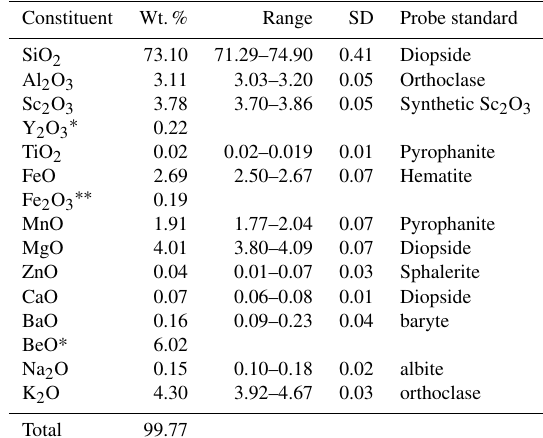
Table 3. Trace element contents of laurentthomasite.